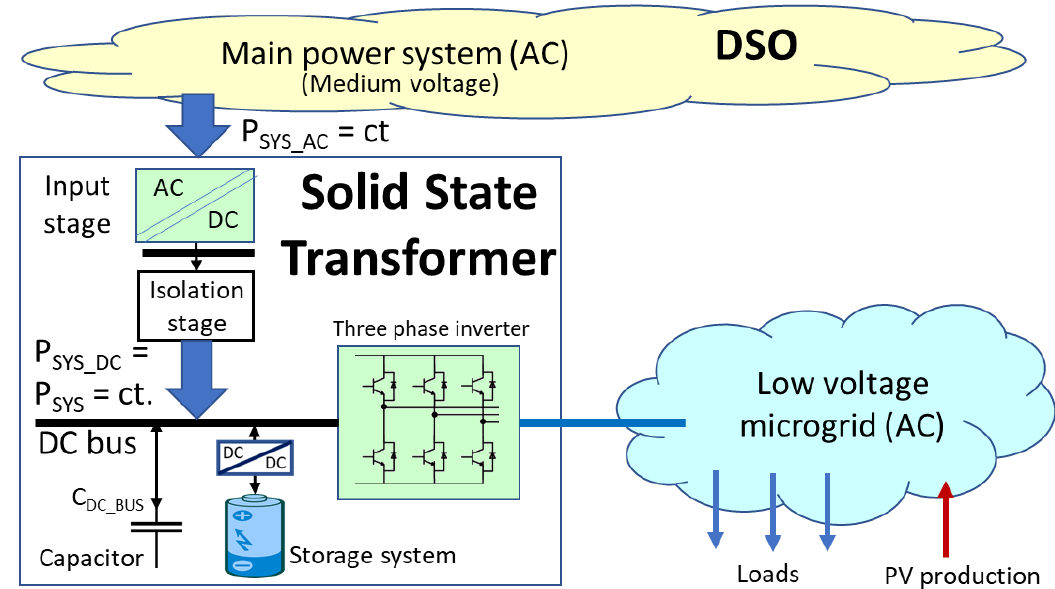
Figure 5. The basic configuration of the proposed SST.